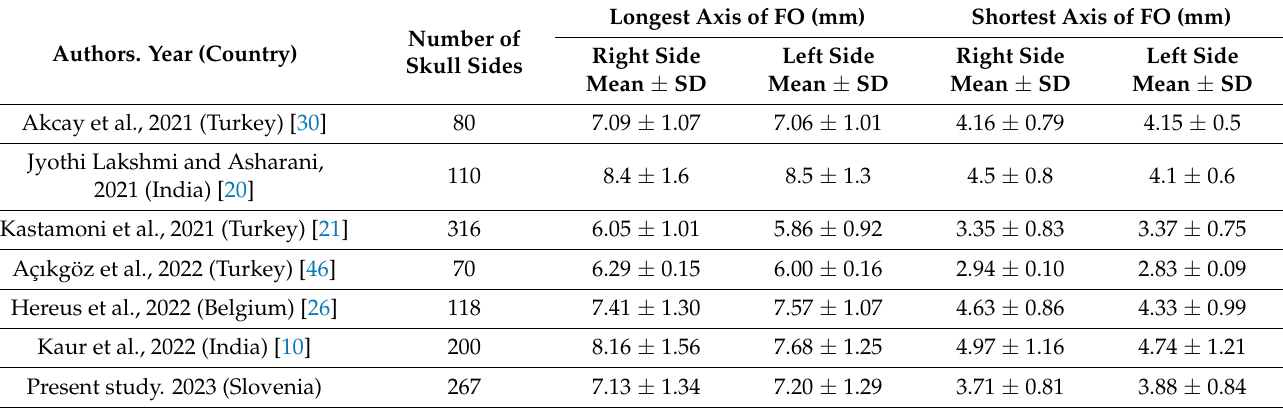
FO—foramen ovale. SD—standard deviation.